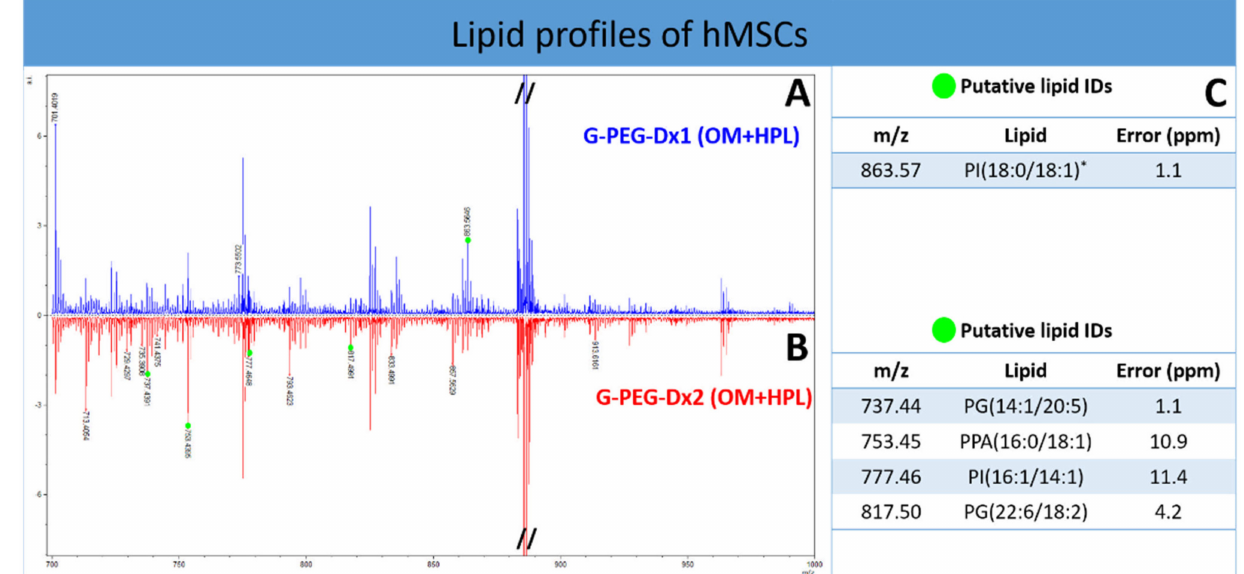
Figure 9. Average lipid profiles of hMSCs in G-PEG-Dx1 and G-PEG-Dx2. ( A , B ) Average lipid profiles of hMSCs in G-PEG-Dx1 (OM+HPL) (blue) and G-PEG-Dx2 (OM+HPL) (red) within the m / z 700 to 1000 range. Annotated m / z values indicate the discriminatory ions highlighted by supervised statistical analysis and green dots indicate those assigned with a putative lipid ID. ( C ) The putative lipid IDs associated with G-PEG-Dx1 (OM+HPL) (blue) and G-PEG-Dx2 (OM+HPL), respectively. Error values are presented in ppm. * denotes that the lipid ID was confirmed by MALDI-MS/MS and the product ions generated from its dissociation are presented in Supplementary Table